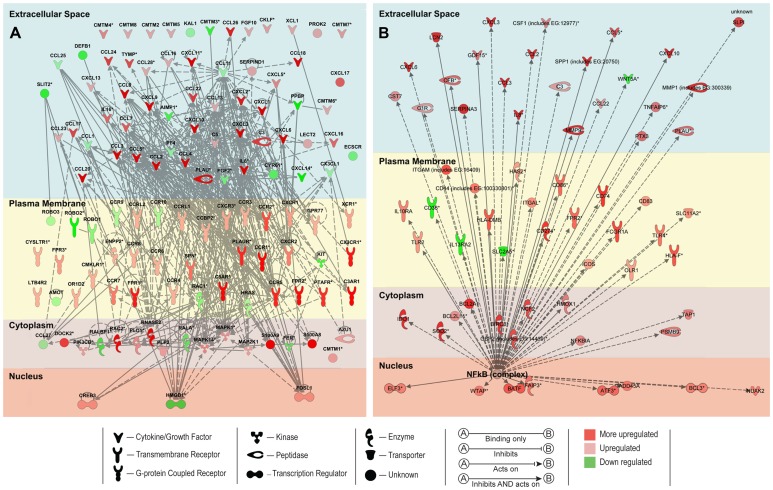
Comparison of the microarray and qRT-PCR analysis.The x-axis represents individual genes and the y-axis fold-change in expression by either microarray (gray bars) or RT-PCR (black bars). All genes shown were significant in the unadjusted microarray analysis. Genes that were significantly up- or downregulated by RT-PCR between GBS and controls are indicated by a star (two-sided t-test, p<0.05).